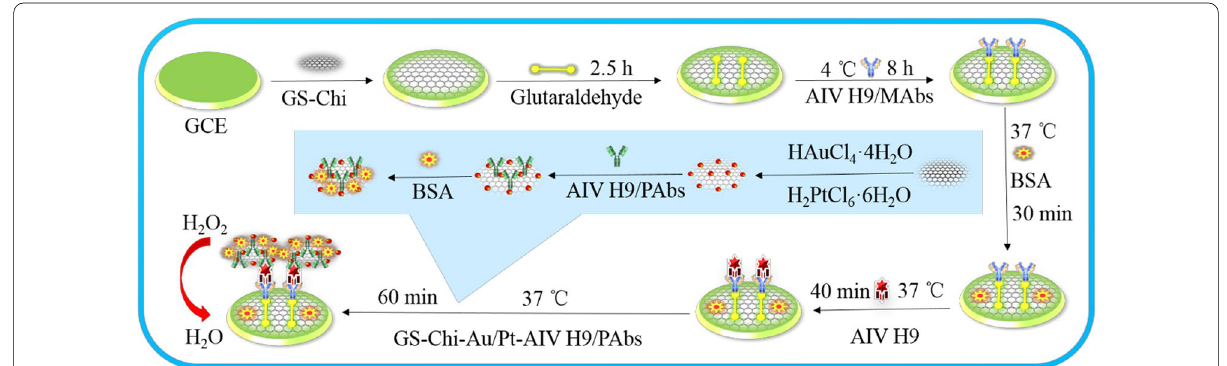
Fig. 1 Schematic illustrating the electrochemical